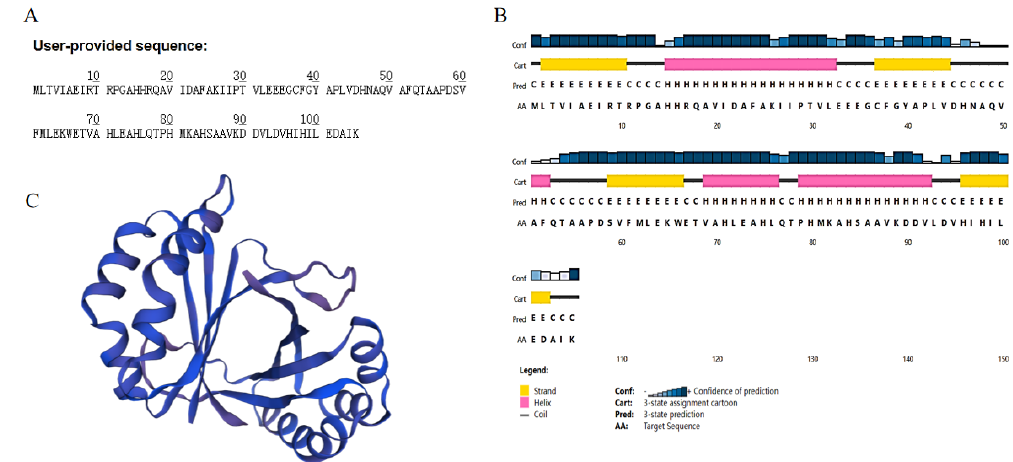
Figure 3. Bioinformatics analysis of BuMO. ( A )—The primary structure. ( B )—The secondary structure. ( C )—The tertiary structure.